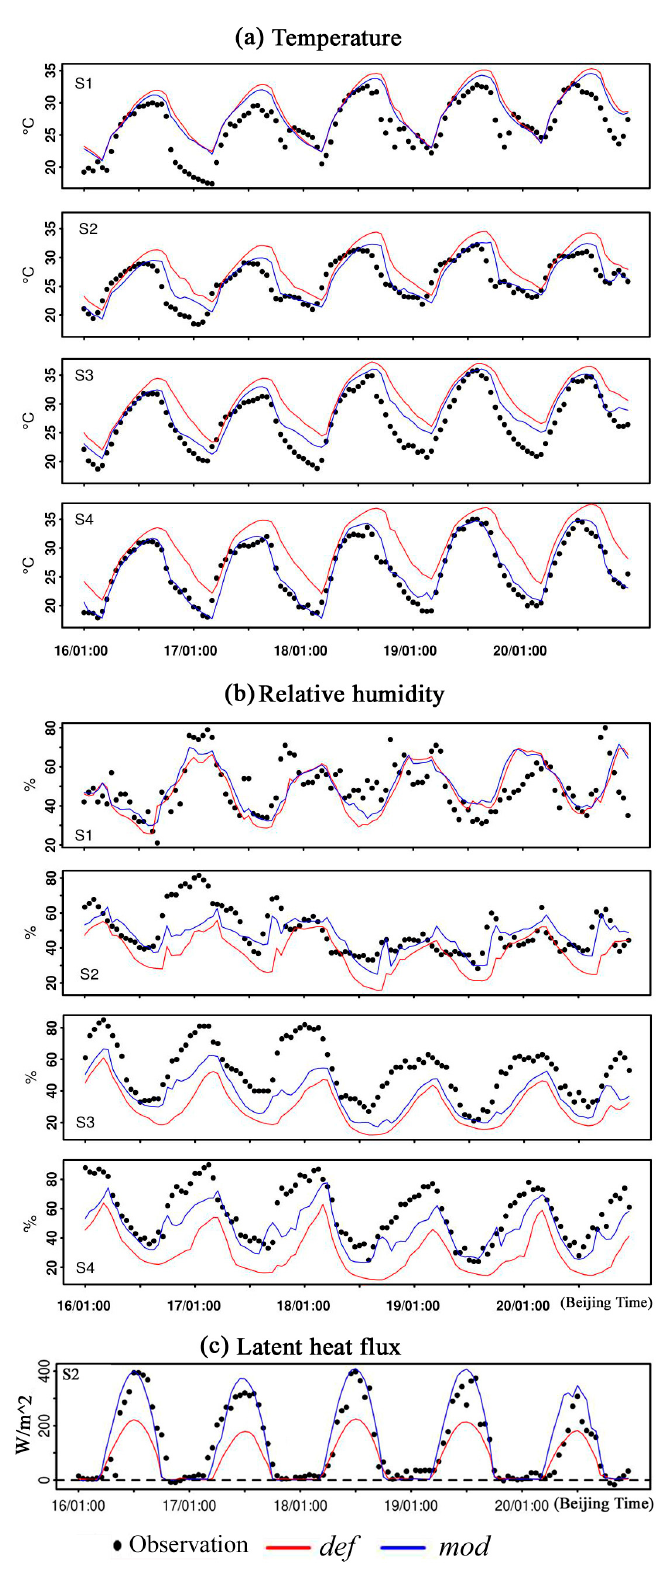
Figure 3. Comparisons of the observed and simulated ( a ) 2-m air temperature (T2), ( b ) 2-m relative humidity (RH) and ( c ) latent heat flux (LE) at the four stations (S1, S2, S3 and S4) during 16 July to 20 July.